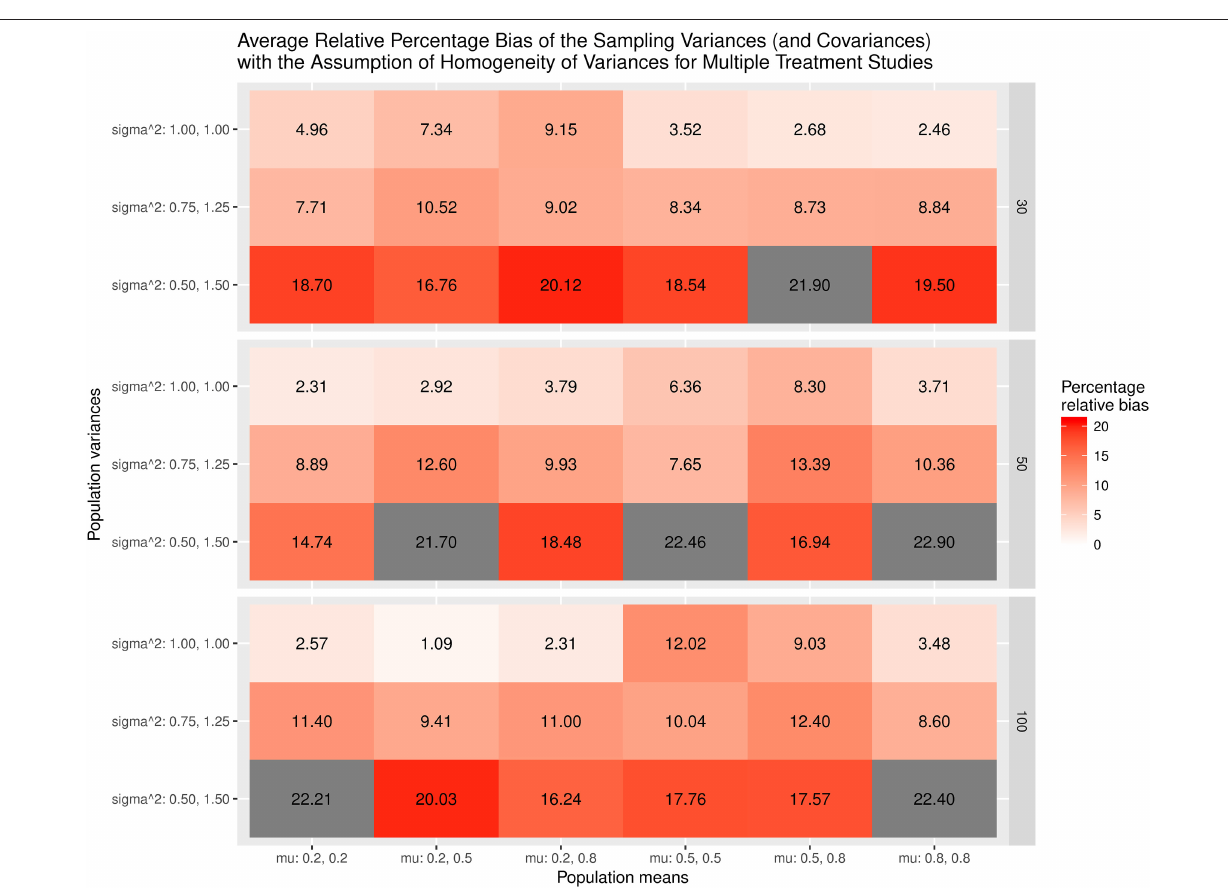
Frontiers in Psychology |